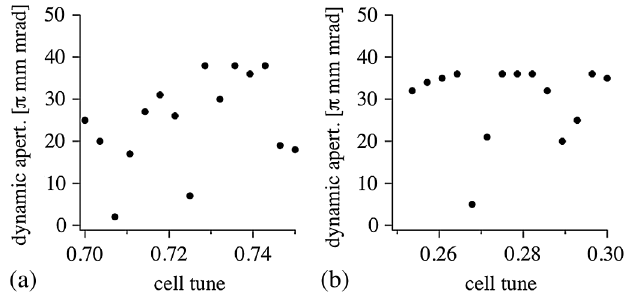
FIG. 12. Dynamic aperture vs (a) horizontal cell tune q (b) vertical cell tune q magnets is used with polynomial fit to the strength up to